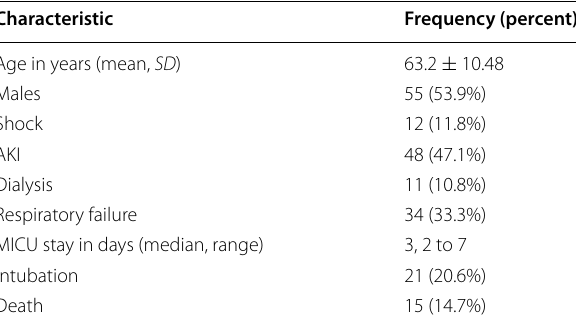
Table 1 Demographic and clinical characteristics of patients